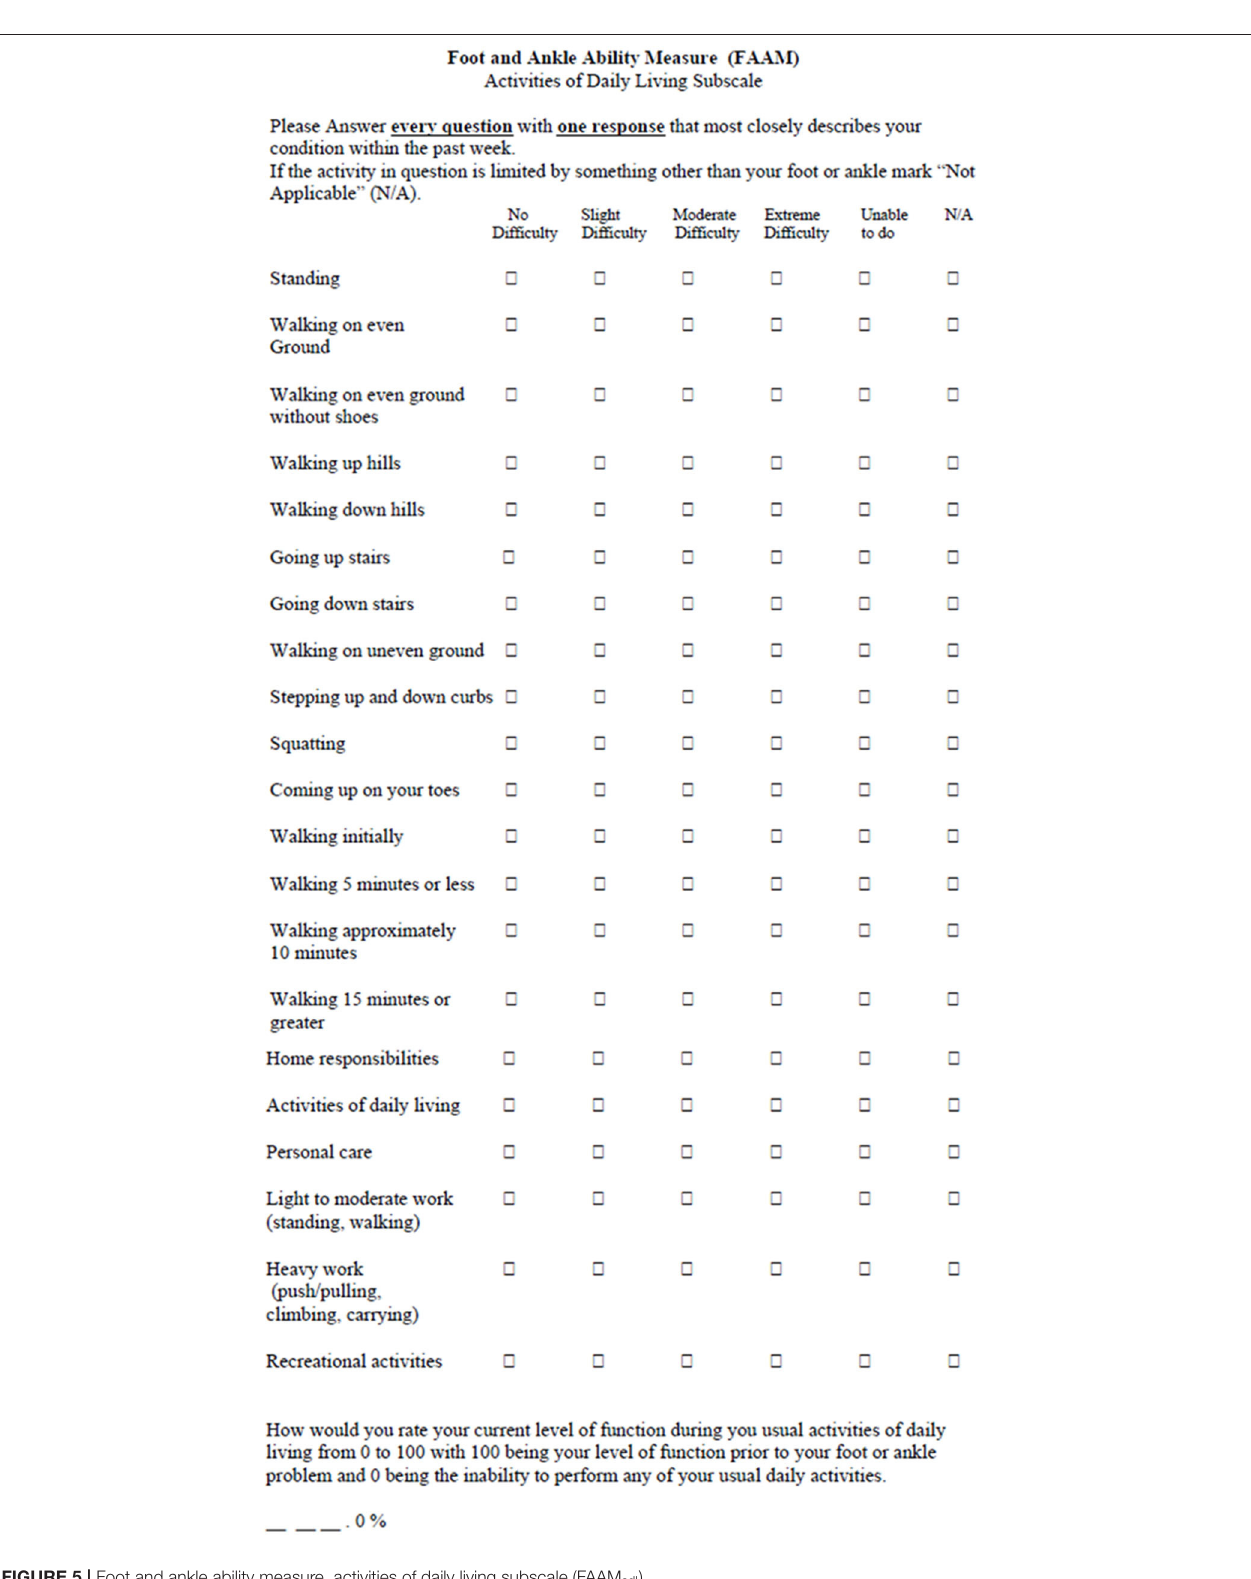
Frontiers in Sports and Active Living |